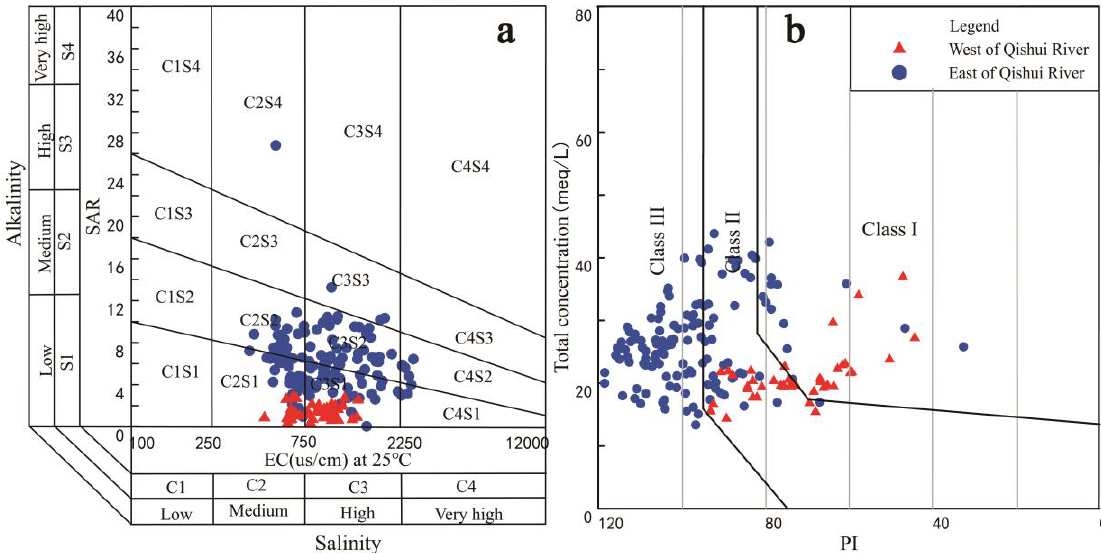
Figure 3. Irrigation water quality assessment based on USSL diagram ( a ) and Wilcox diagram ( b ).